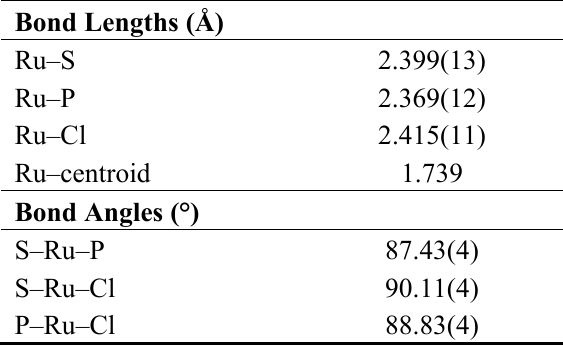
Table 2. Selected bond lengths (Å) and angles (°) of 11